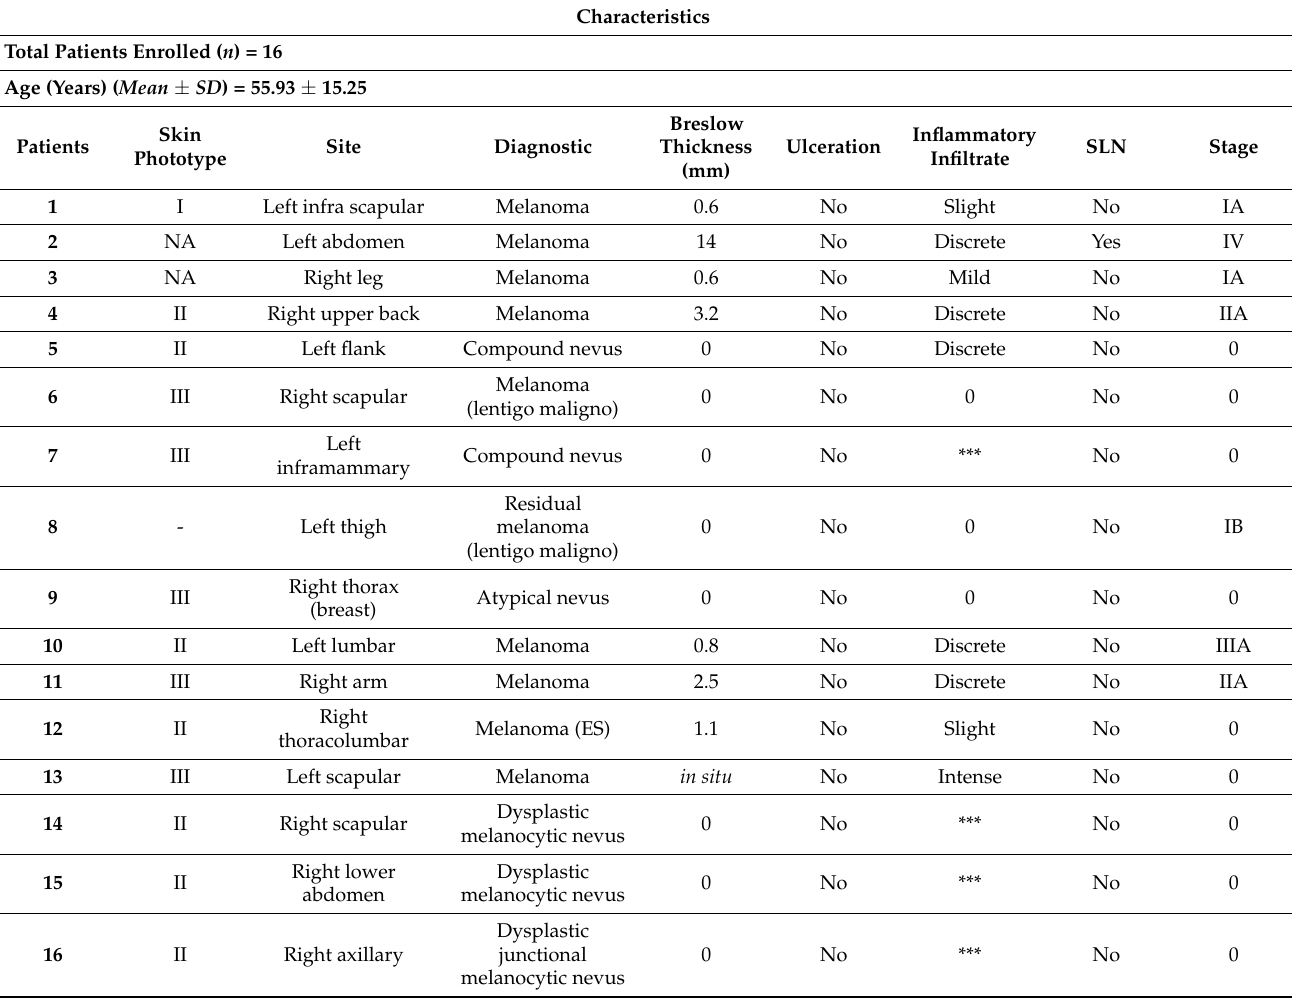
Table 1. Characteristics of patient’s sample. ***: absence. SLN: sentinel lymph node.